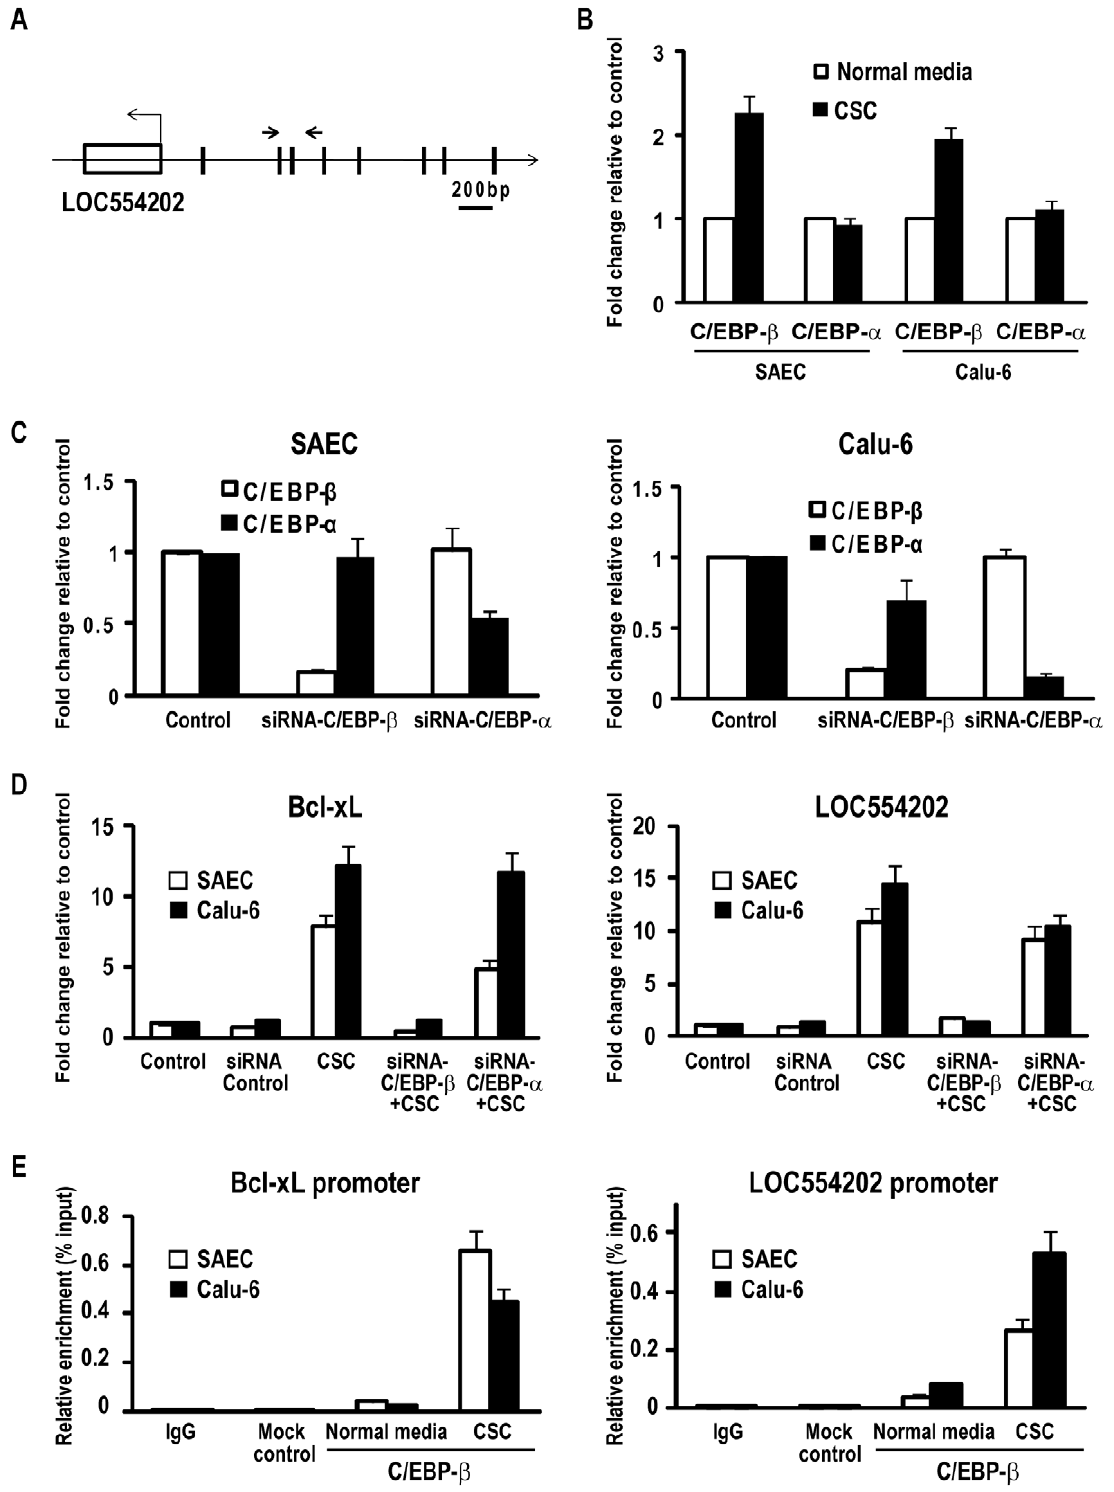
Figure 5. C/EBP- b mediates CSC-induced miR-31 transcription. A) Schematic representation of putative binding sites of C/EBP- b (vertical bars) in the LOC554202 promoter. The arrows show the positions of ChIP primers for C/EBP- b . B) qRT-PCR analysis demonstrating that CSC enhances C/ EBP- b but not C/EBP- a expression in SAEC and Calu-6 cells. C) qRT-PCR analysis demonstrating specificity of siRNAs targeting C/EBP- b and C/EBP- a in SAEC and Calu-6 cells. D) Left panel: qRT-PCR analysis of Bcl-xL expression in SAEC and Calu-6 cells cultured in the presence or absence of CSC following knock-down of C/EBP- b or C/EBP- a . CSC exposure dramatically increases Bcl-xL expression in SAEC and Calu-6 cells. Knock-down of C/EBP- b expression decreases activation of Bcl-xL by CSC. This phenomenon was not nearly as dramatic following knock-down of C/EBP- a . Right panel: qRT- PCR analysis of LOC554202 expression in SAEC and Calu-6 cells cultured in the presence or absence of CSC following knock-down of C/EBP- b or